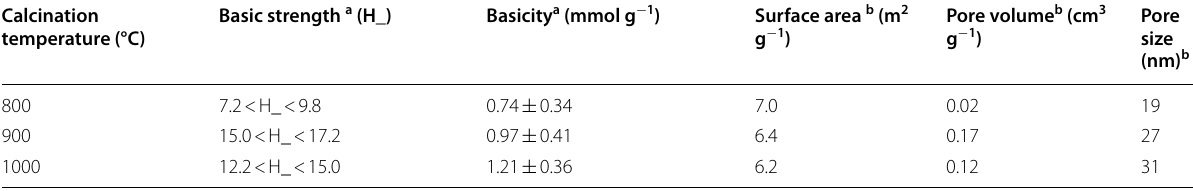
a Determined by Hammett indicator b Analyzed by N 2